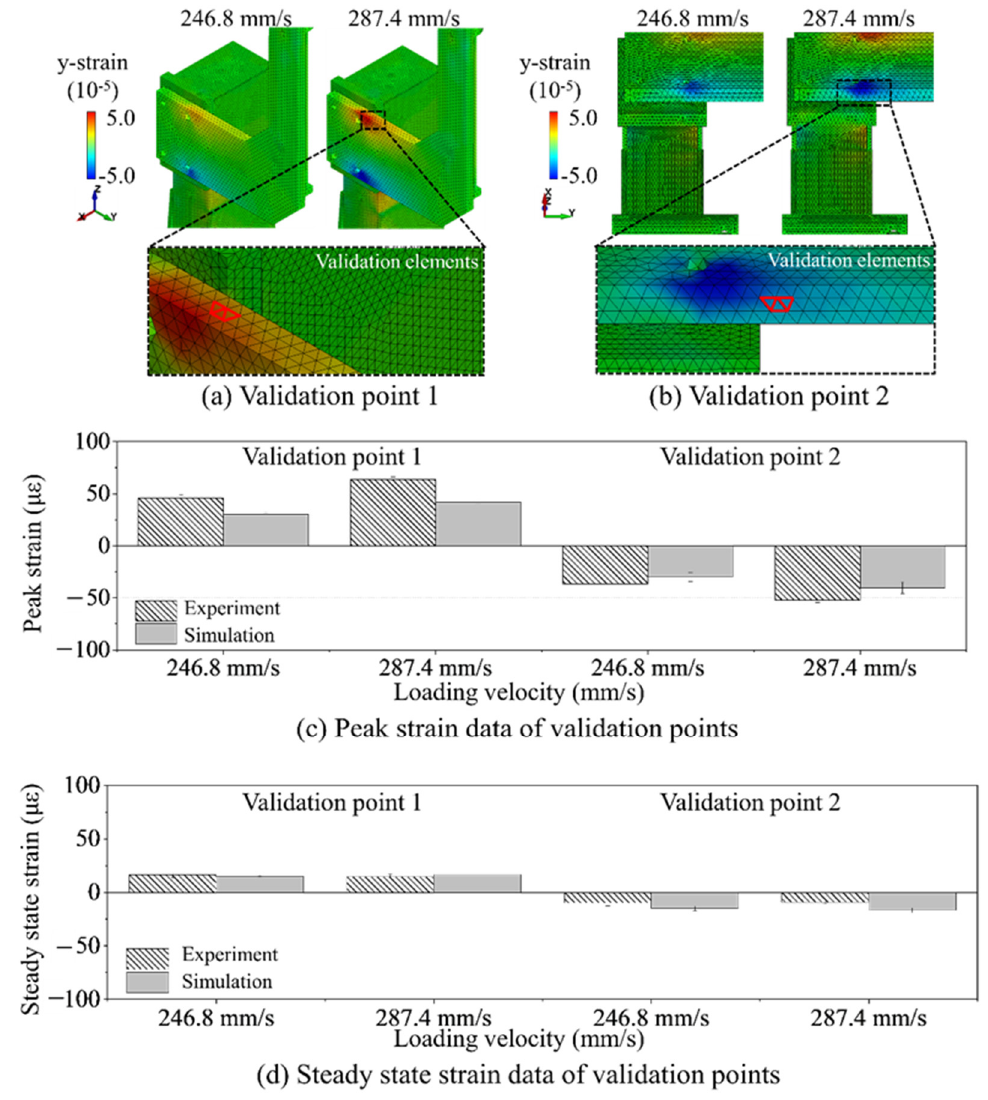
Figure 10. Validation of reconstructed impact load with production equipment. ( a ) Contour repre- sentations of y-axis strain distribution with validation elements of Validation point 1; ( b ) contour representations of y-axis strain distribution with validation elements of Validation point 2; ( c ) comparison of experimentally measured and numerically calculated peak strain; ( d ) comparison of experimentally measured and numerically calculated strain in steady state.